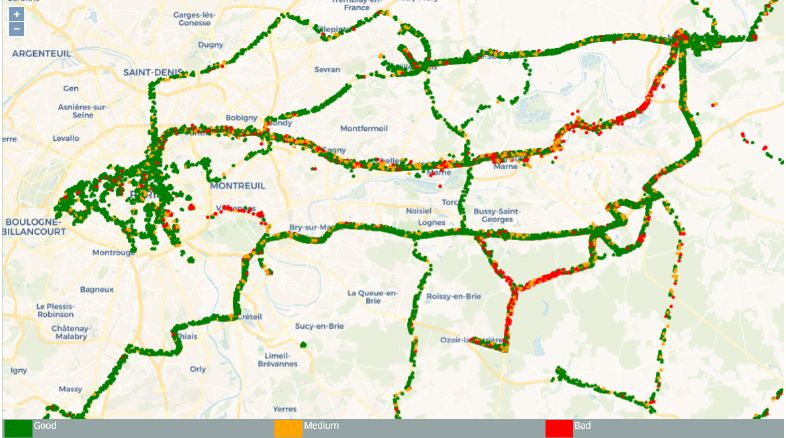
Figure 3. A simple bitrate-based service status overview of the measured traces in the Île-de- France